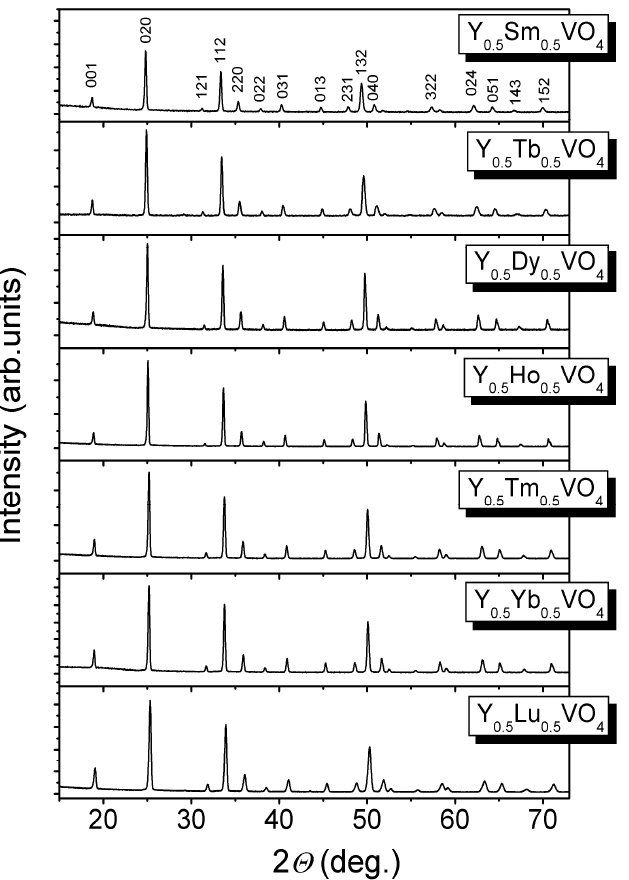
Figure 1. Representative parts of XRD patterns of the Y 0.5 R 0.5 VO 4 ( R = Sm, Tb, Dy, Ho, Tm, Yb, Lu) samples. The Miller indices are given for the zircon-type structure.